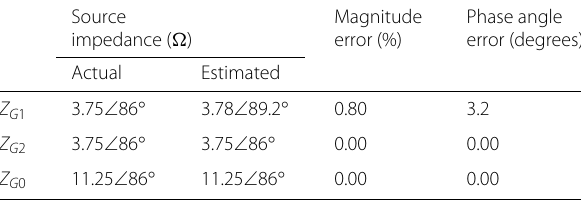
Table 3 Actual vs. Estimated Thevenin impedances at Terminal G for the three-terminal line test